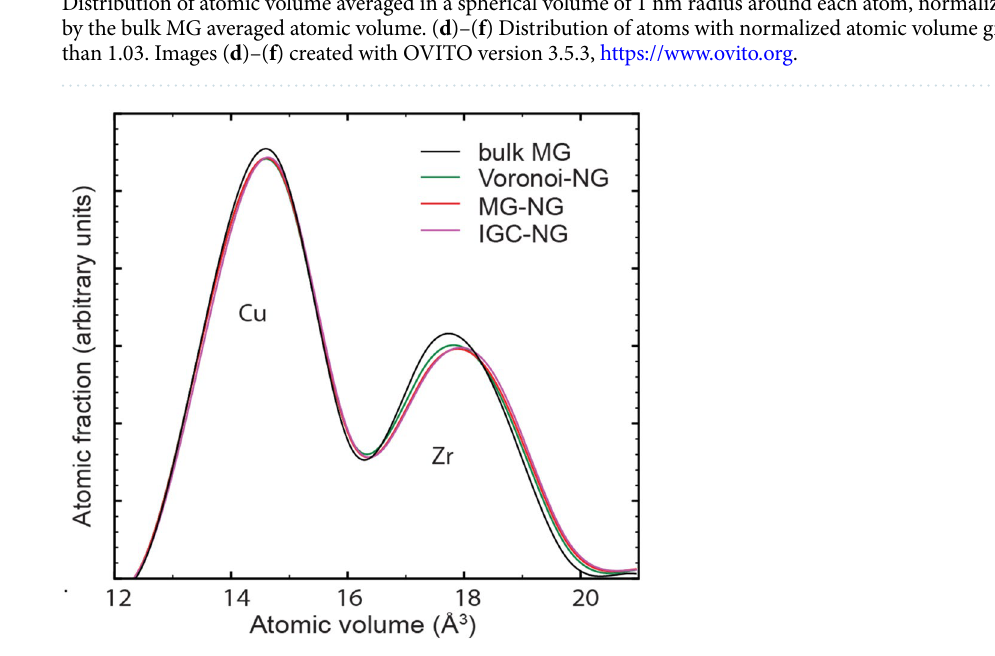
Figure 5. Voronoi atomic volume distribution in different NG models as compared to their bulk MG parent. The peaks corresponding to Cu and Zr contributions are